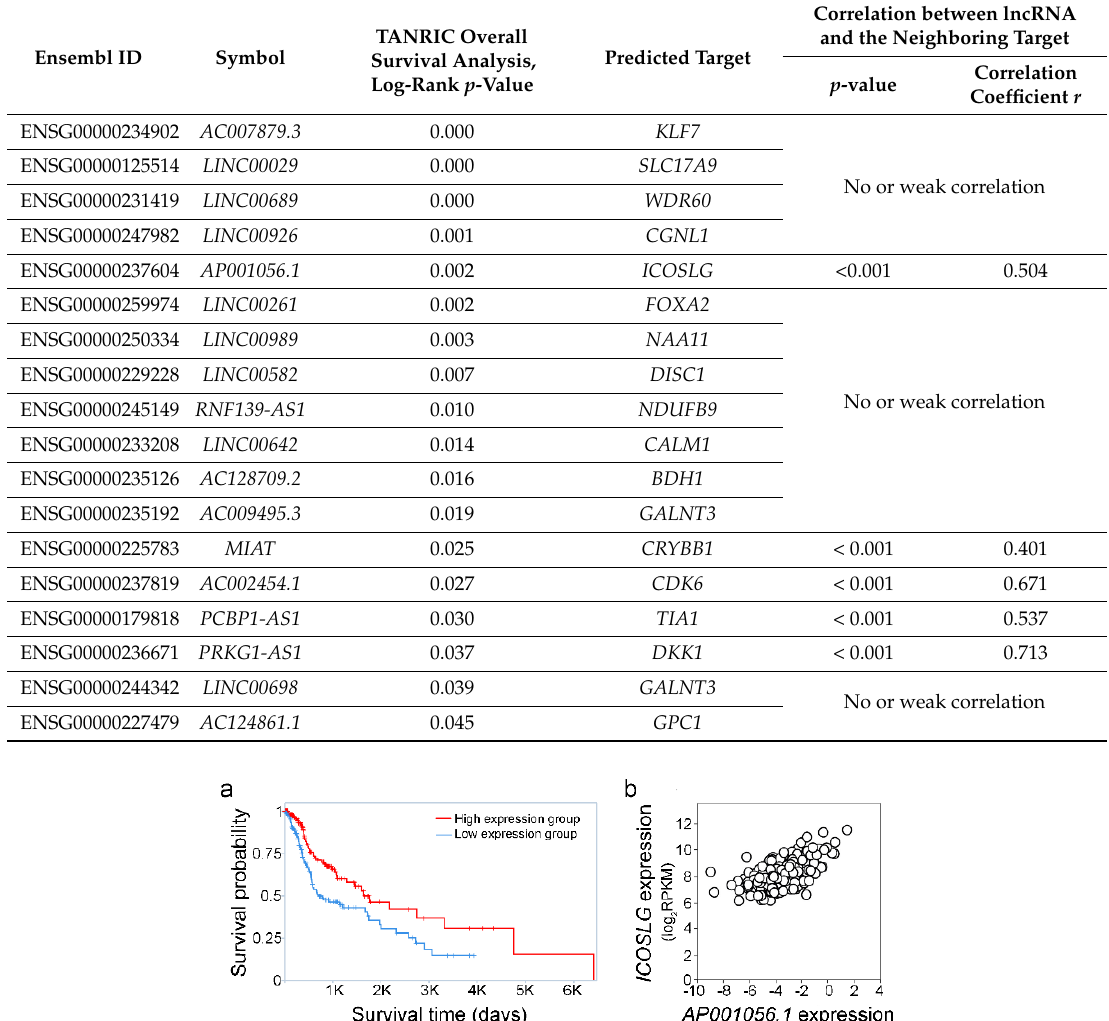
Table 1. List of overall survival associated lncRNAs derived from enhancers.